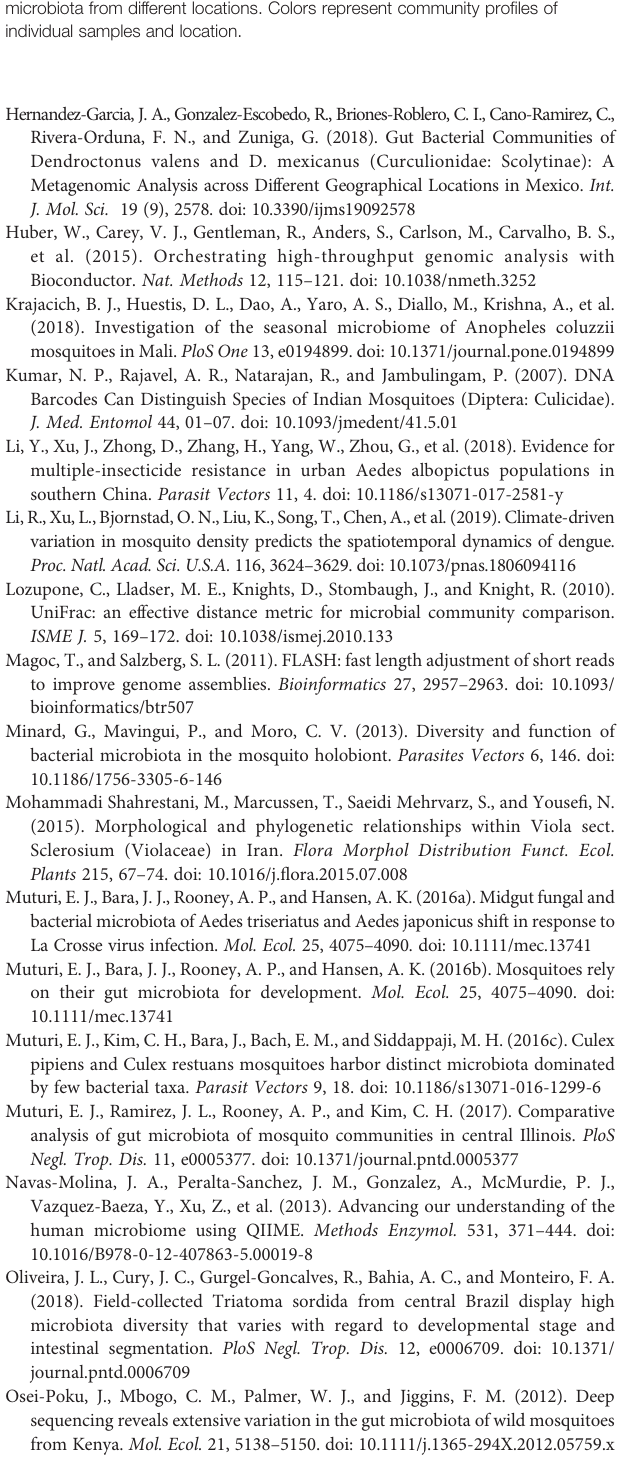
LD = Ledong, LS = Ledong, SY = Sanya, TC = Tunchang, WC = Wenchang, WZS = Wuzhishan; AAL = Aedes albopictus , ASU = Armigeres subalbatus , CGE = Culex gelidus , AGA = Aedes galloisi , CPA = Culex pallidothorax , CPI = Culex pipiens . SUPPLEMENTARY FIGURE 2 | PCoA plot (A – C) based on an unweighted Unifrac distance matrix depicting differences in the composition of the gut microbiota from different locations. Colors represent community pro fi les of individual samples and